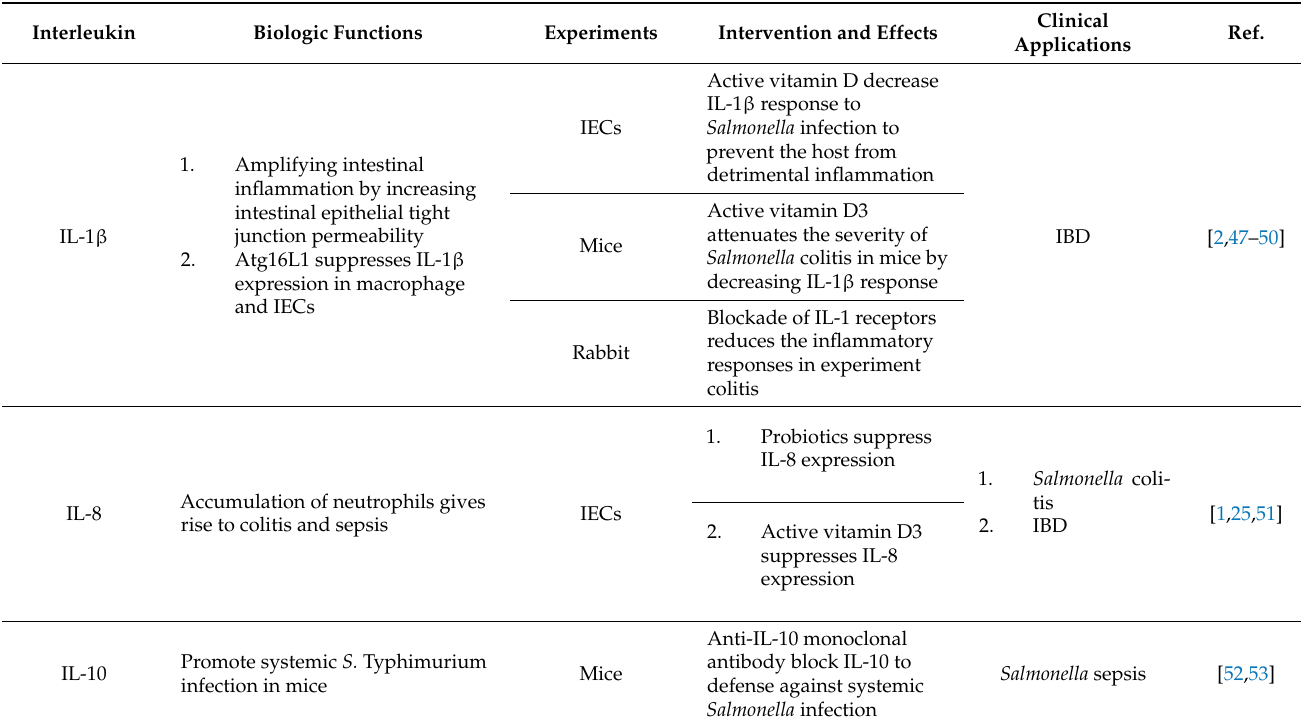
Table 2. The interleukins orchestrate mucosal immune responses to enhance Salmonella colitis.